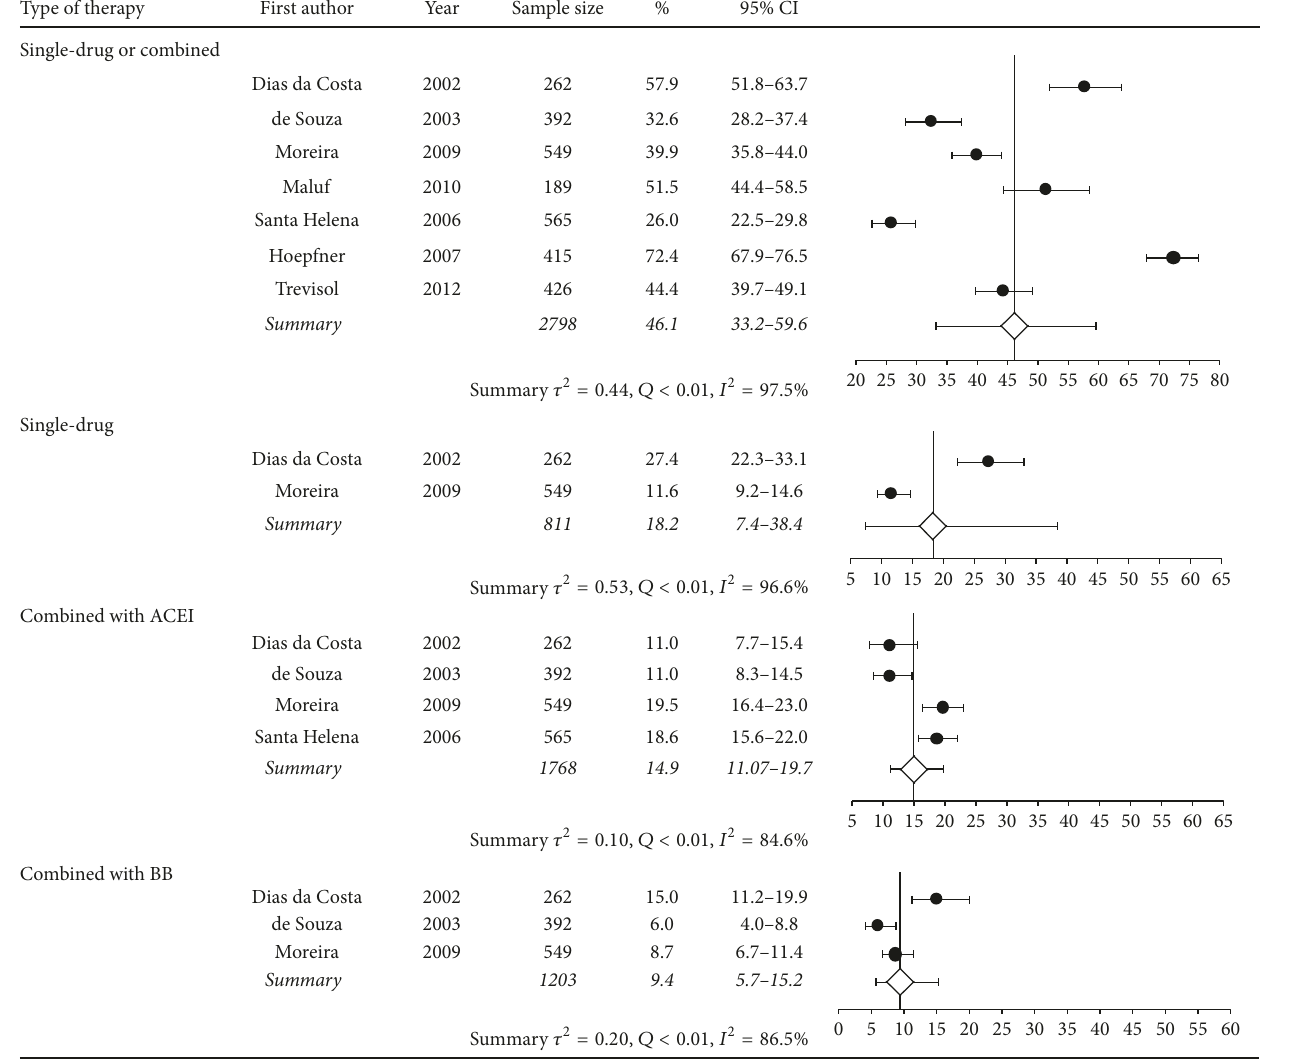
Figure 4: Meta-analysis of proportion of use of thiazide-based